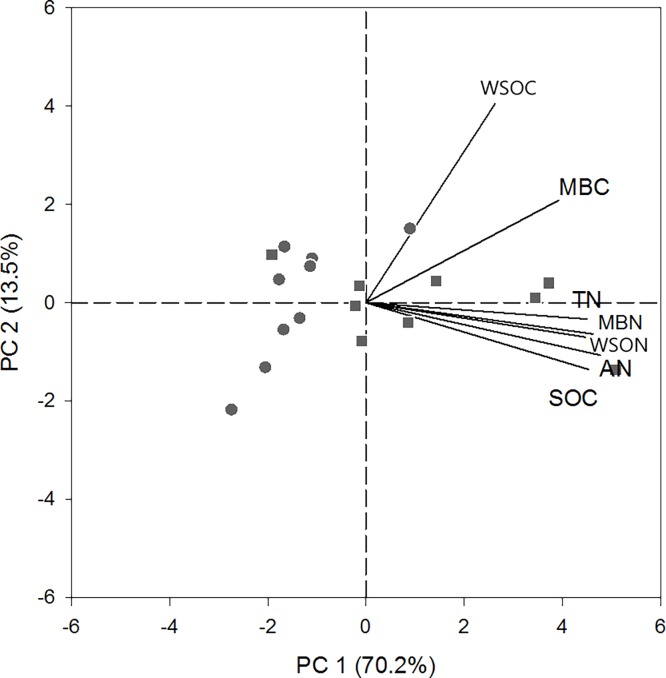
Principal components analysis (PCA) of C and N variables based on measurements from all plots.Filled circles, Dicranopteris; filled squares, graminoids.